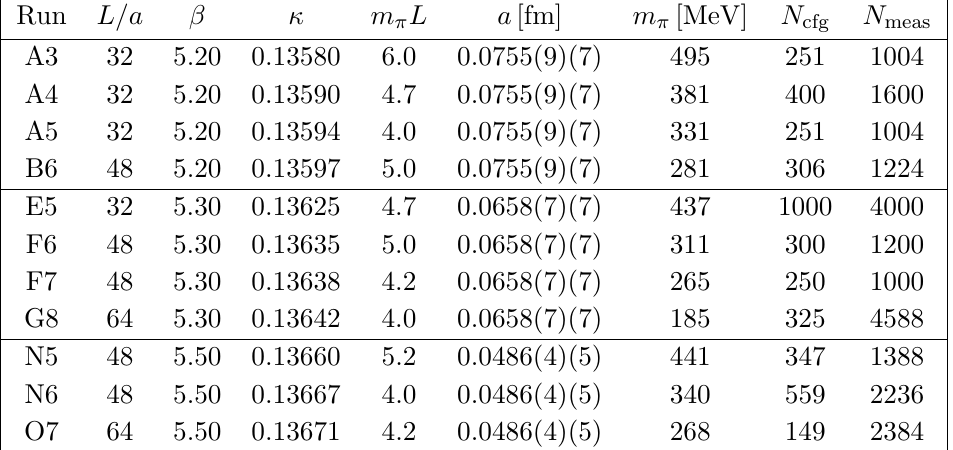
Table 1 . Details of the lattice ensembles used in the calculation of the hadronic vacuum polariza- tion, showing the lattice extent, L , where T = 2 L , the values of the bare coupling (cid:12) and light quark hopping parameter (cid:20) in the lattice action, as well as the lattice spacing and pion masses in physical units. N cfg and N meas denote the number of gauge con(cid:12)gurations and measurements,